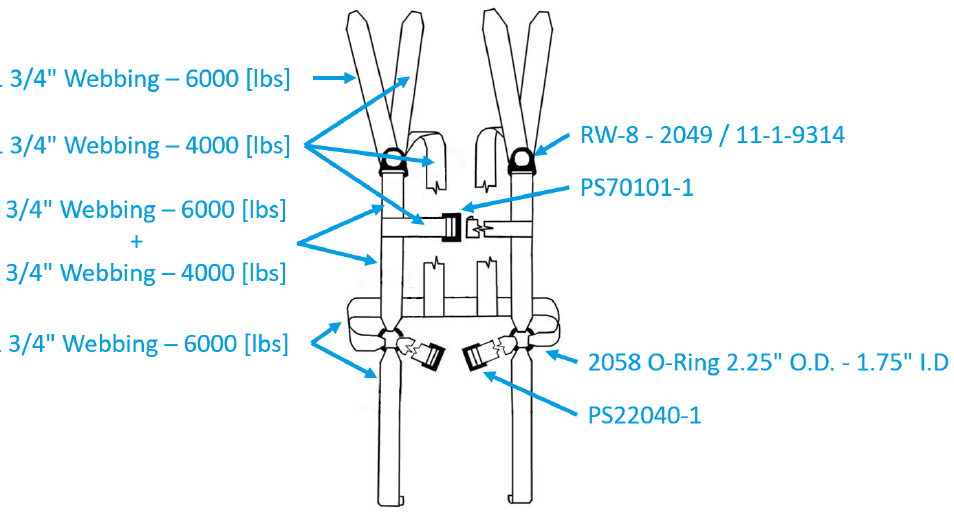
Figure 1. Scheme of used